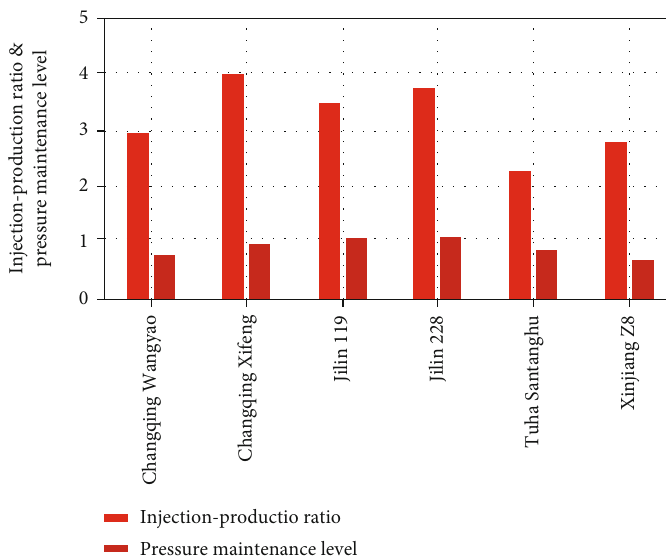
Figure 1: Injection-production ratio and pressure retention levels in typical reservoirs.